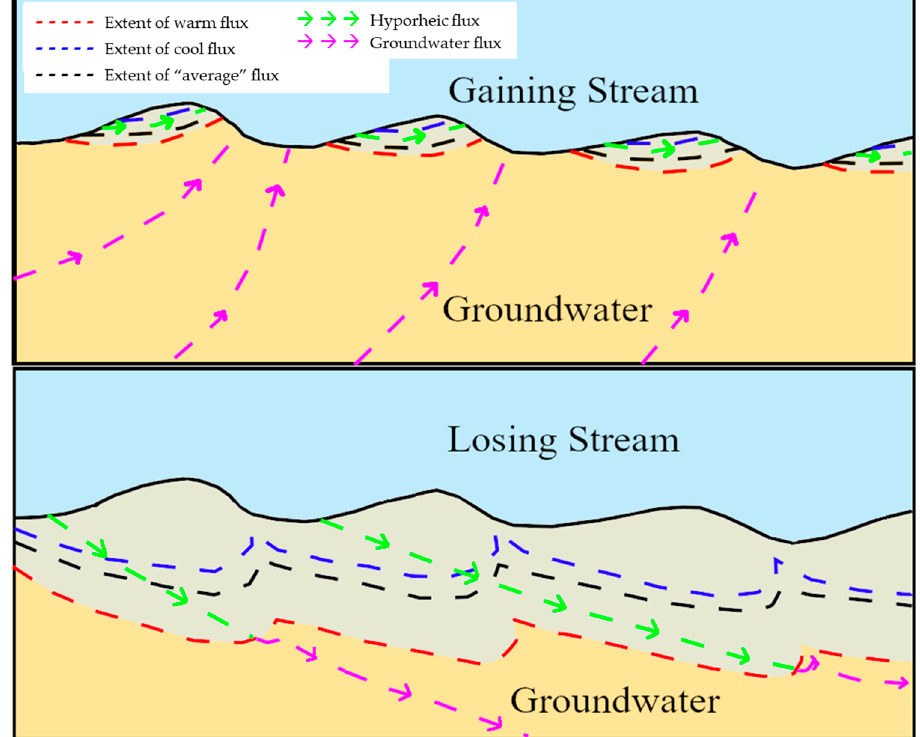
Figure 5. Conceptual model of alterations to HZ from temperature under gaining and losing condi- tions. The blue dashed line represents the theoretical extent of cool flux under either condition, and the red dashed line represents the theoretical extent of warm flux under either condition.